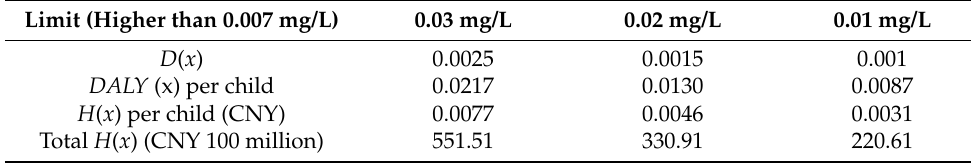
Table 4. Consumer loss due to the limit change. Limit (Higher than 0.007